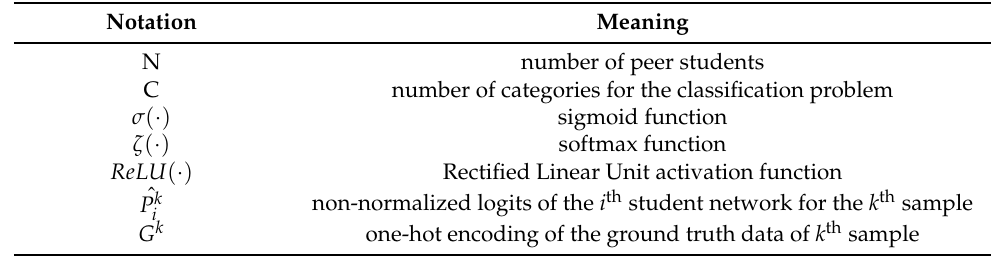
one-hot encoding of the ground truth data of k th